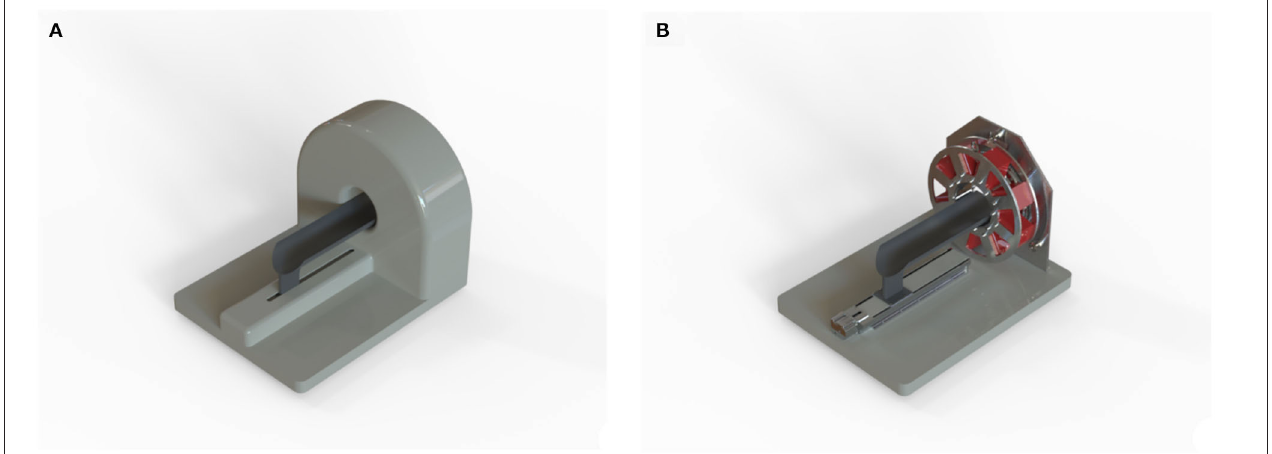
FIGURE 2 | Dedicated SPECT system for in-vivo preclinical molecular imaging; (A) 3D rendering of the system. (B) Inner structure that shows the eight detector heads mounted on a rotary stage.